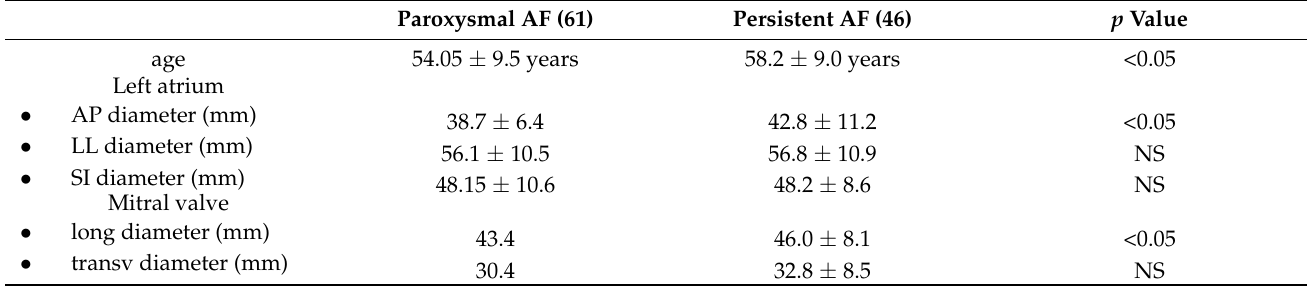
Table 2. Comparison between LA and MV diameters in both paroxysmal and persistent